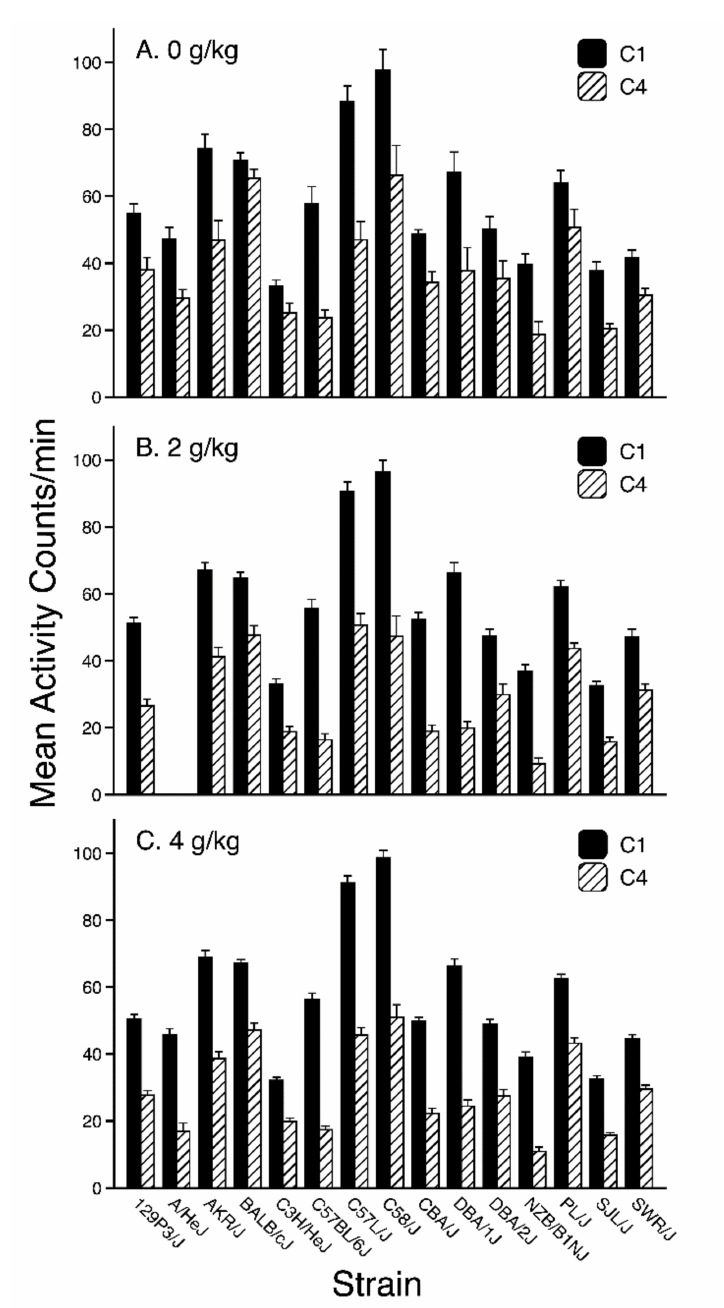
Figure 1. Mean ( + SEM) activity rates (counts per minute) on the first (C1: Solid bars) and last (C4: Cross-hatched bars) pairs of conditioning trials for each strain within the ( A ) 0 g / kg, ( B ) 2 g / kg, and ( C ) 4 g / kg dose groups (collapsed across conditioning subgroups). Activity was averaged across the CS + and CS − trials since there was no e ff ect of trial type. Each bar for the 0-g / kg group represents 9–13 mice, whereas each bar for the ethanol-injected groups represents 18–25